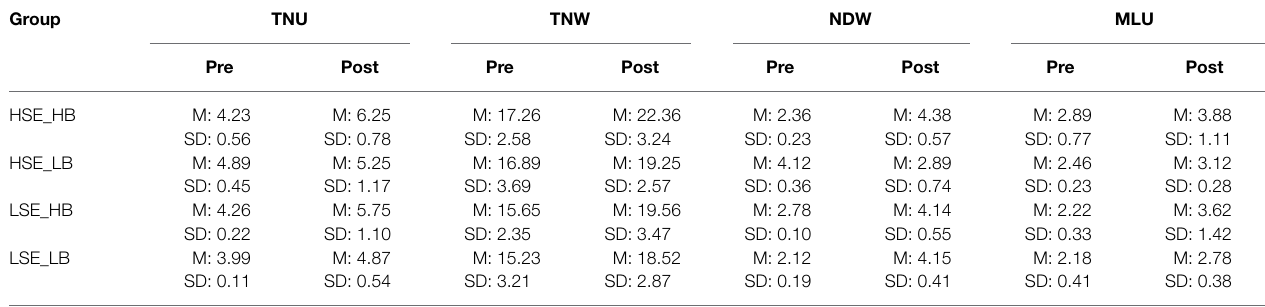
TABLE 5 | The interaction effects of SES and background TV. Group TNU TNW NDW MLU Pre Post Pre Post Pre Post Pre